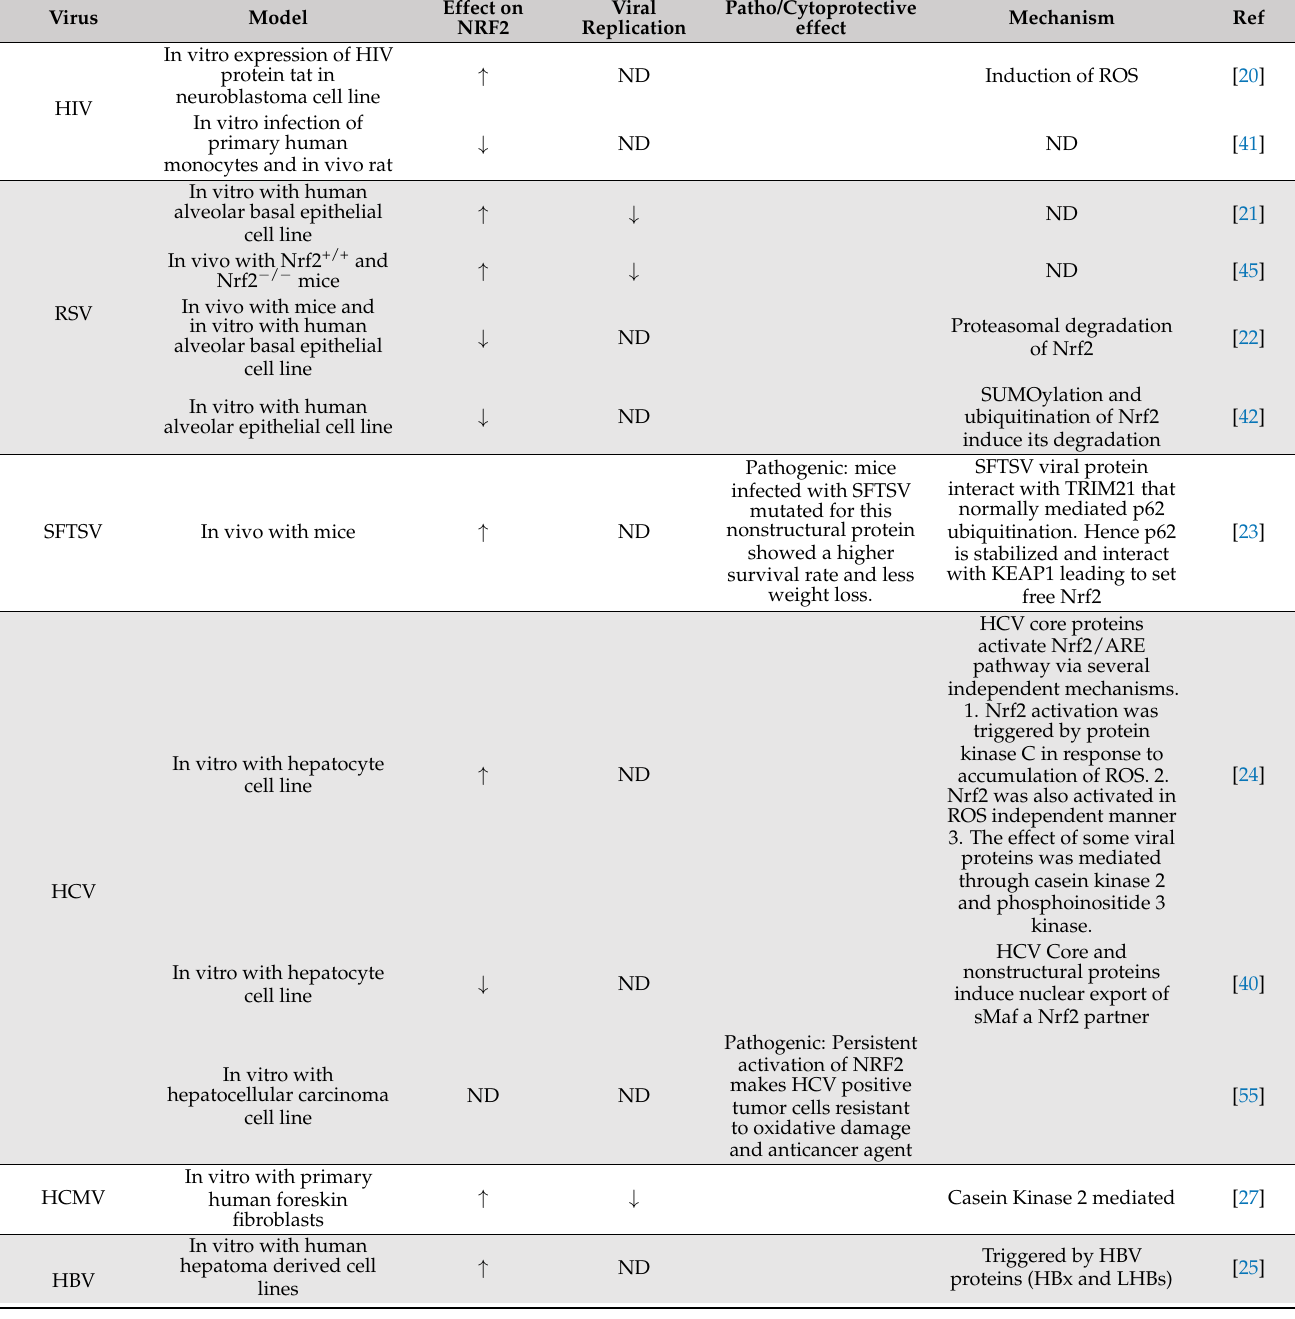
Table 1. Viruses and NRF2 among